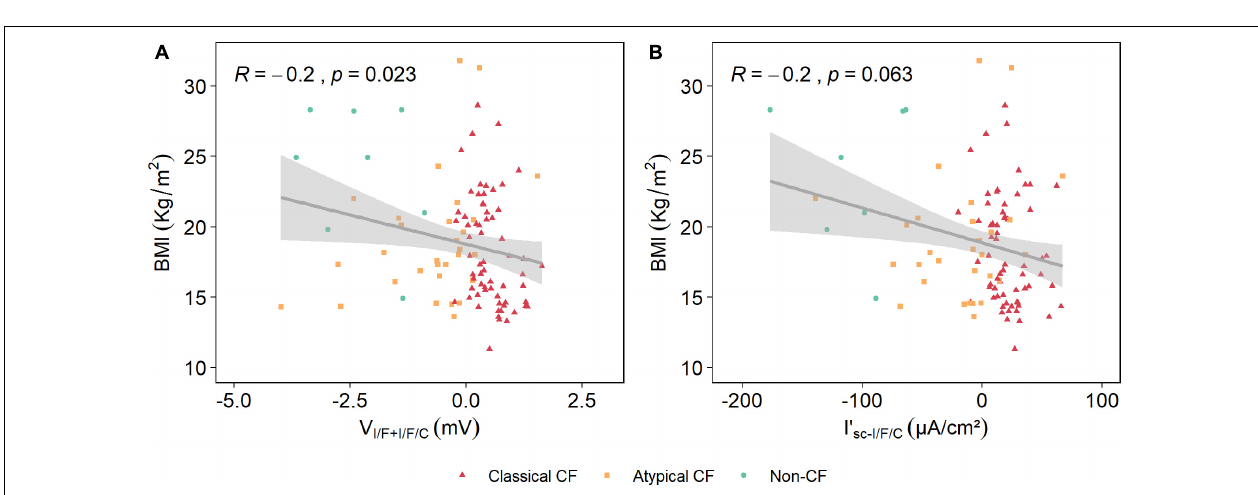
FIGURE 5 | Correlation between age-stratified forced expiratory volume in 1 s [FEV 1 (%)] and V I / F + I / F / C . (A) FEV 1 distributed by age groups show a significant correlation of 50% between FEV 1 and V I / F + I / F / C for the 3–9 years sub-group. (B) Distribution of V I / F + I / F / C values in individuals with FEV 1 < 80% and ≥ 80% show that those with worst pulmonary function also have higher values of V I / F + I / F / C , whereas individuals with better pulmonary function have lower V I / F + I / F / C values (i.e., higher CFTR function). Significant differences were found between these two groups by a Kruskal–Wallis rank sum test (* p ≤ 0.05).